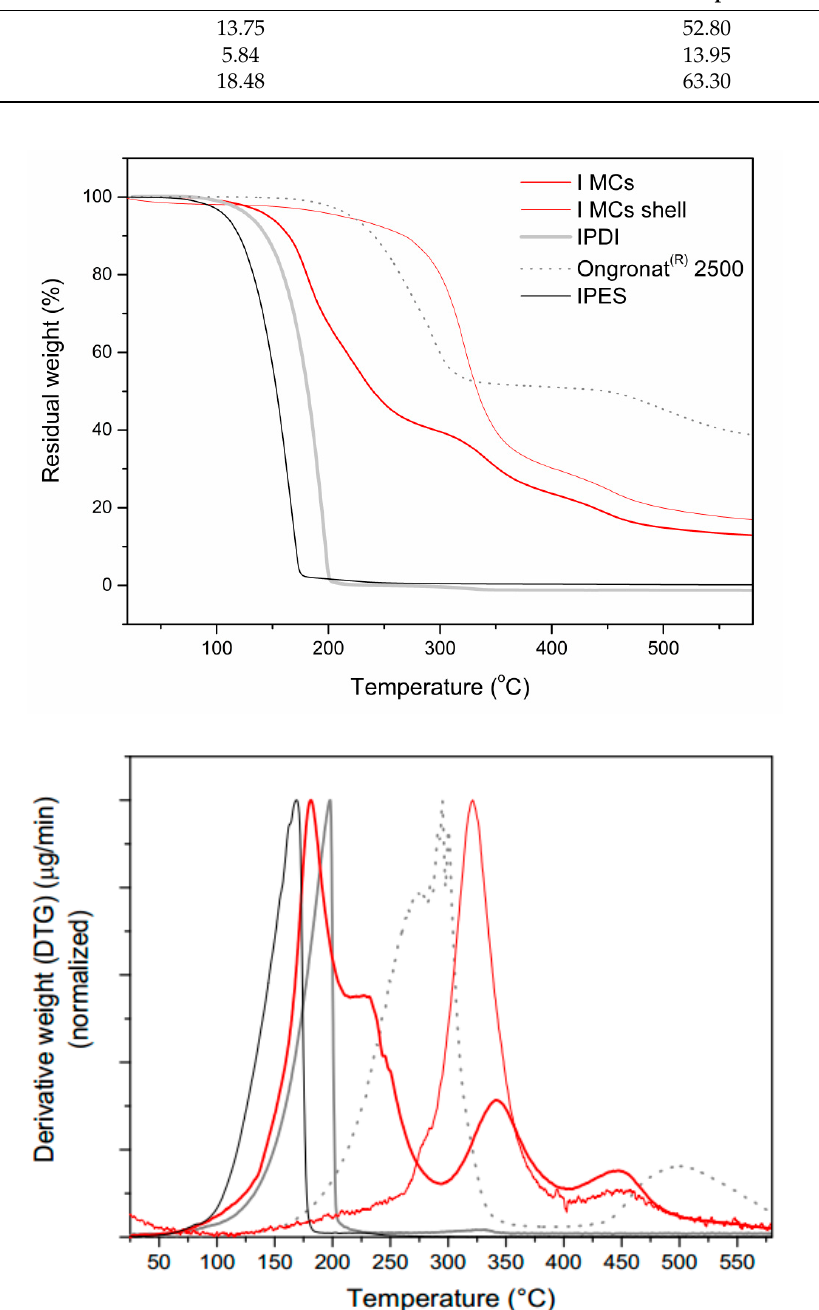
Figure 12. Thermogram of the I MCs, the respective shell and the isocyanates used in the synthesis ( top ) and respective first derivative curves ( bottom ).